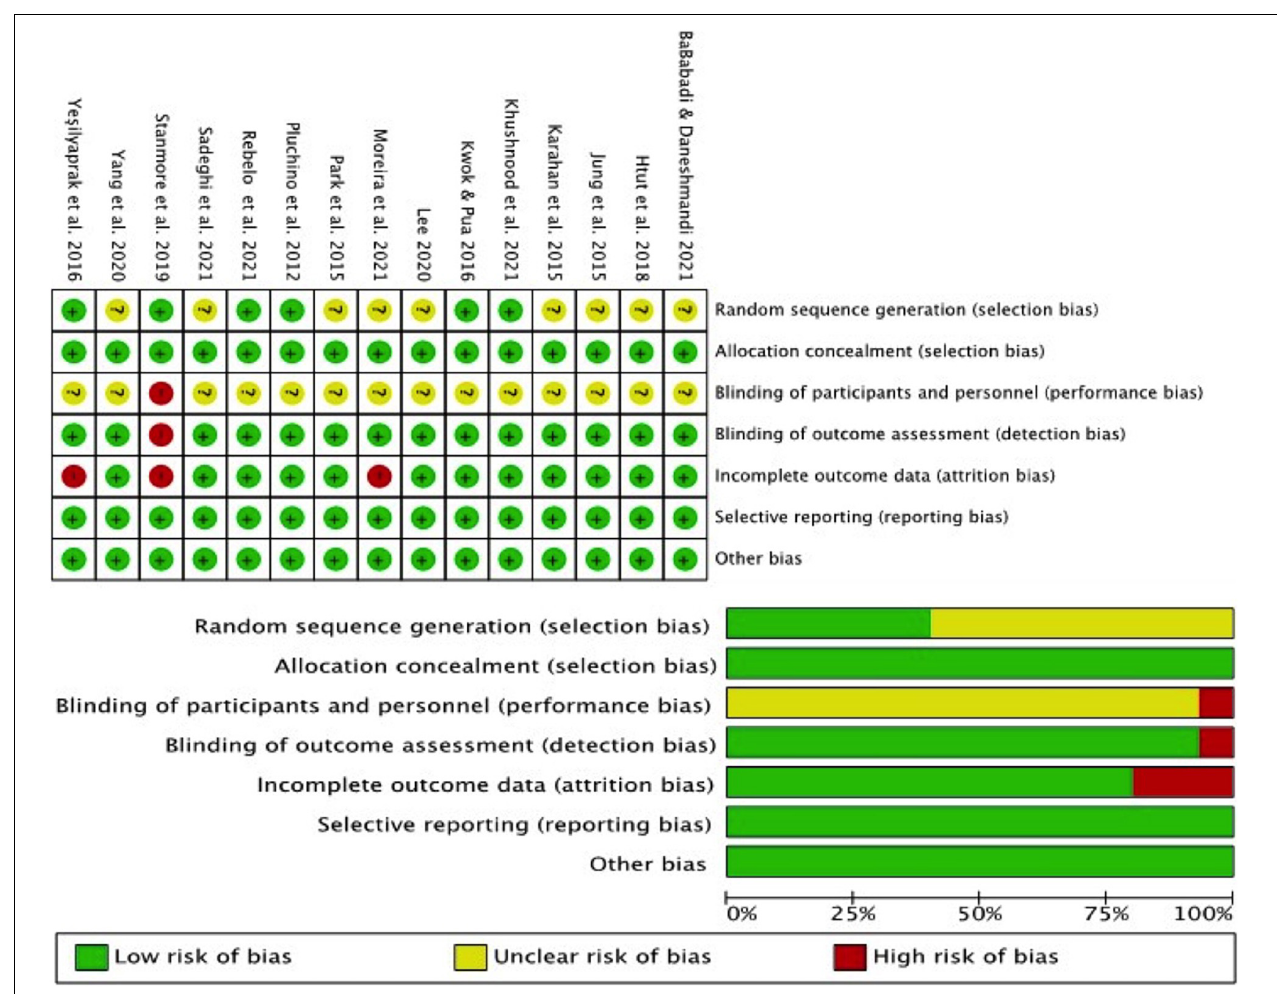
FIGURE 2 | Risk of bias